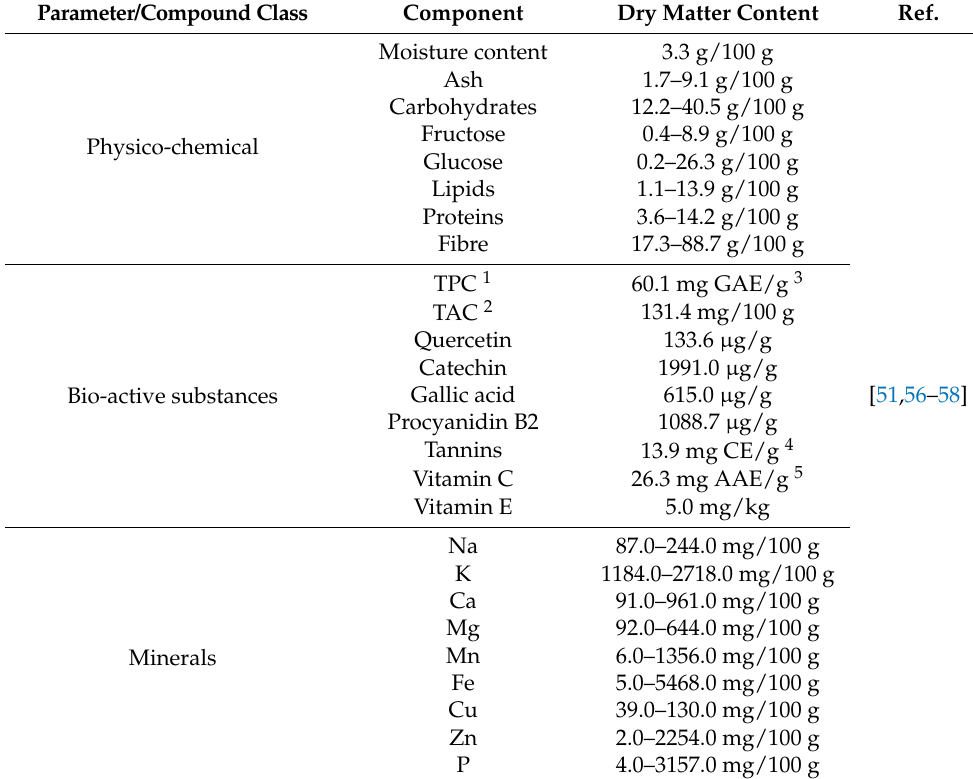
Table 3. Main components of grape